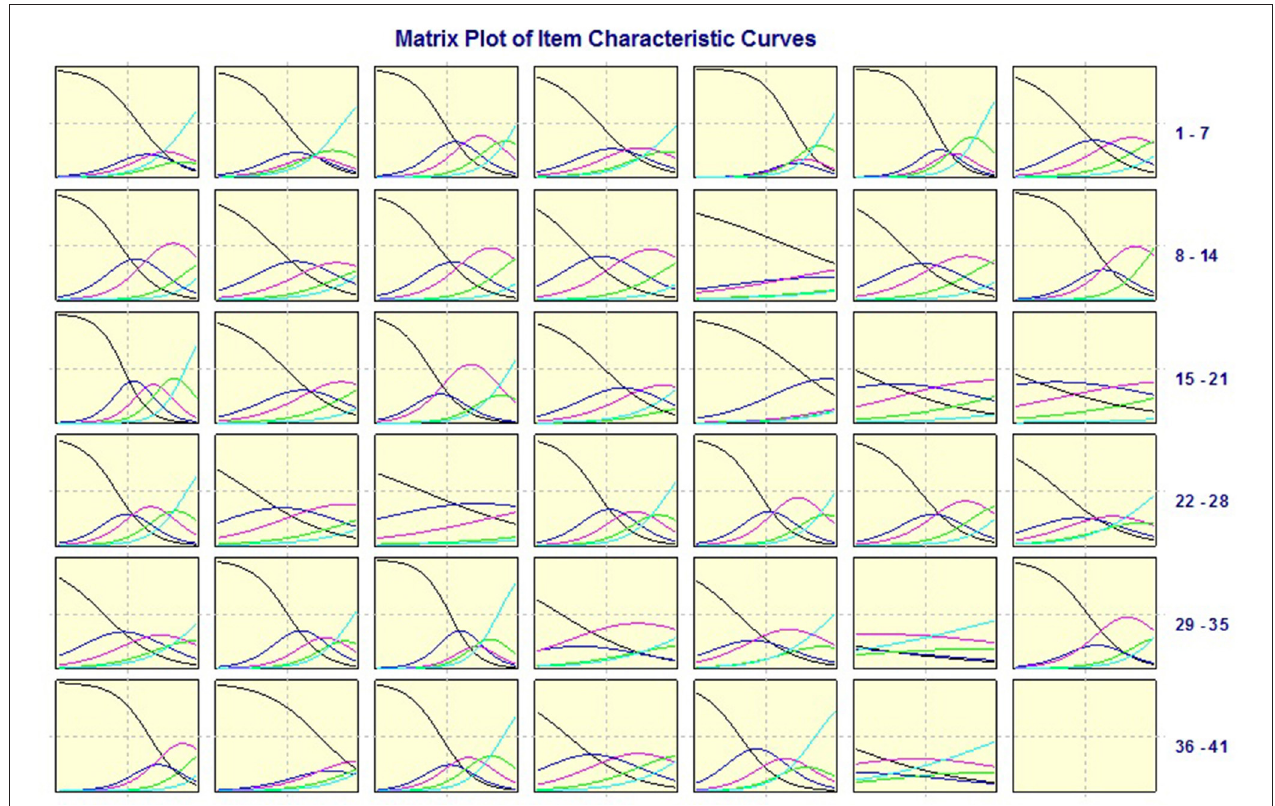
FIGURE 1 | Item characteristic curve matrix